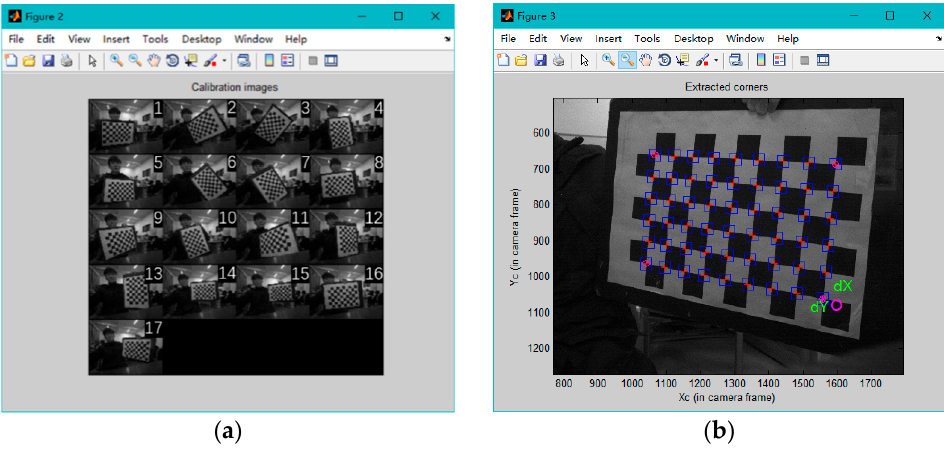
Figure 5. The 17 images loaded by MATLAB and the automatically extracted corners. ( a ) Calibration images. ( b ) Extract corners on the calibration plate images.